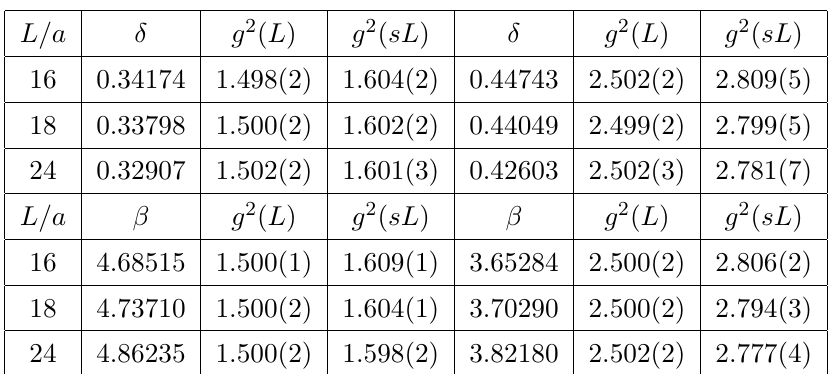
Table 4 . Renormalized couplings, top 3 rows: topological action, bottom 3 rows: Wilson plaquette